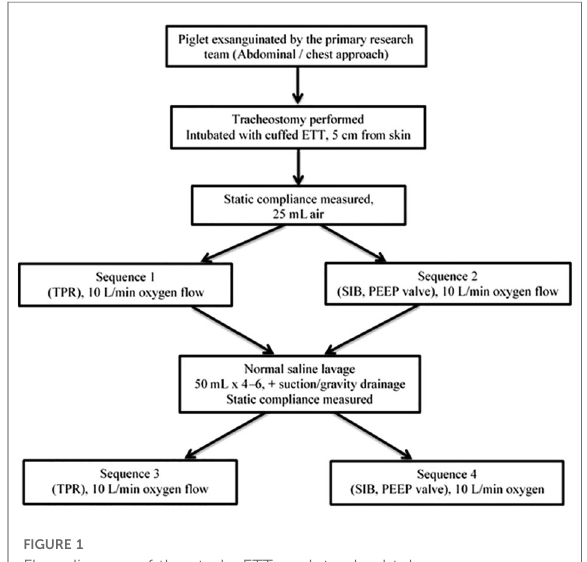
FIGURE 1 Flow diagram of the study. ETT, endotracheal tube.